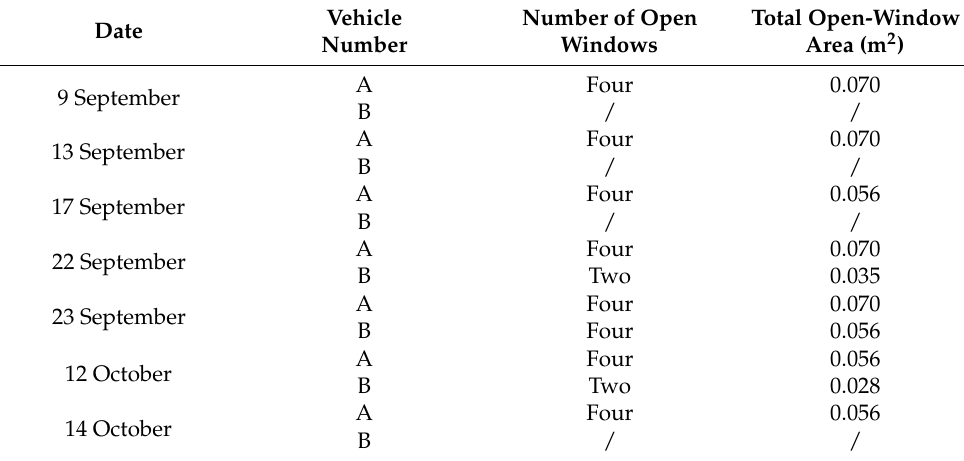
Figure 3. Measuring points in the cabin: ( a ) air and surface temperature measuring points; ( b ) raw picture of the air temperature measuring point. Table 2. Description of the measurement